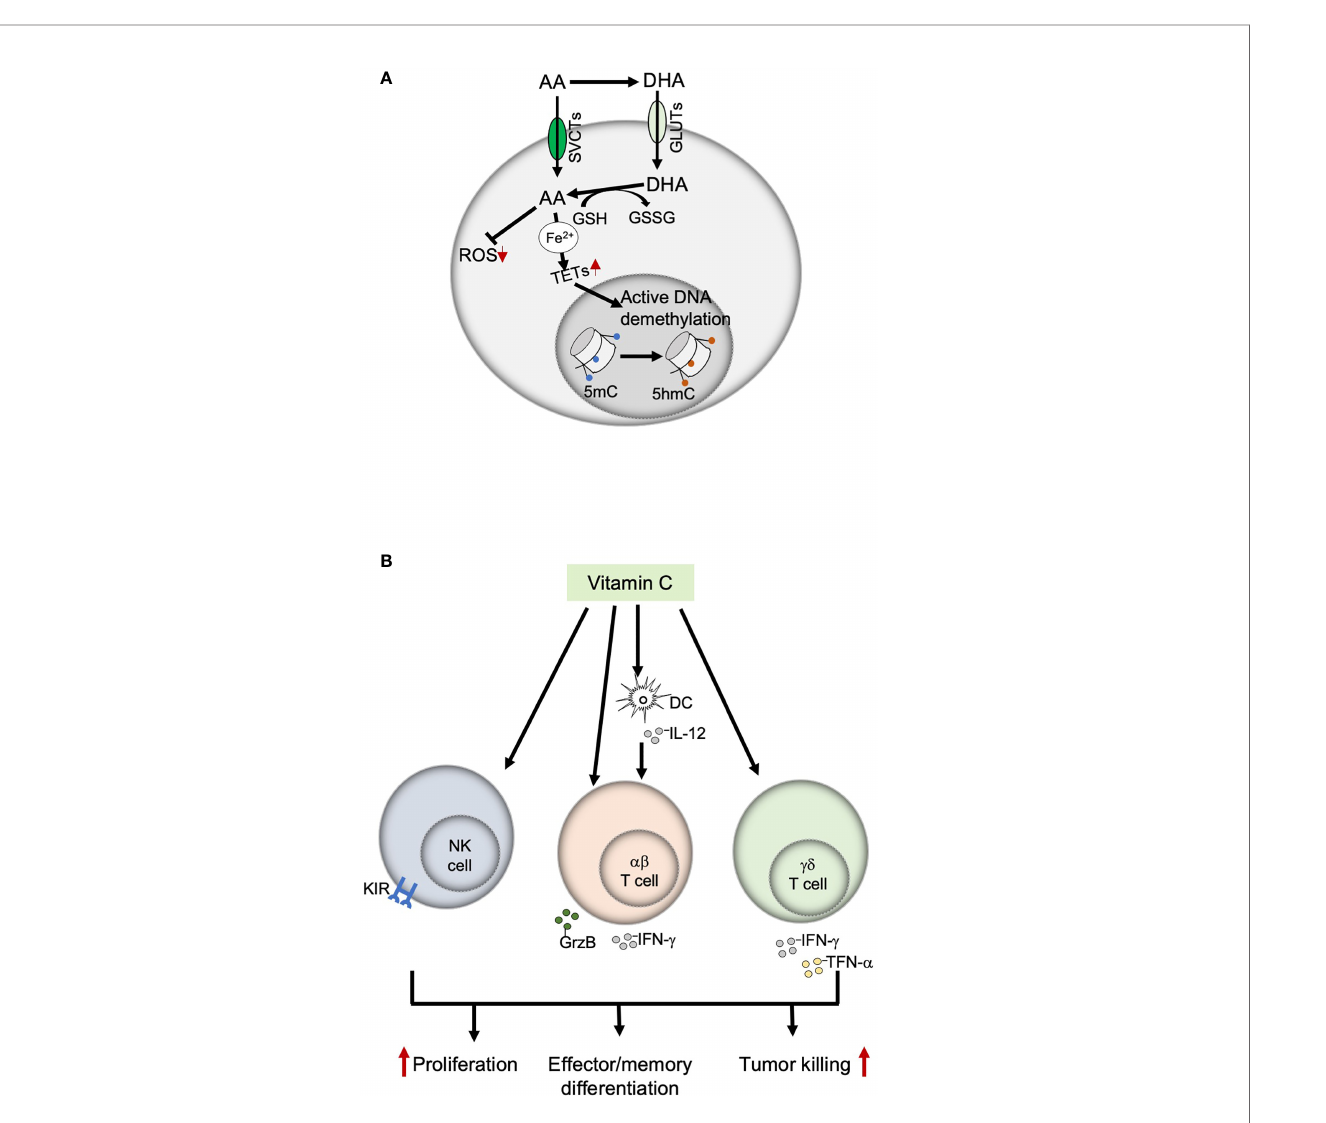
FIGURE 2 | Immunomodulatory functions of Vitamin C. (A) Mechanisms of action of Vitamin C; VitC exerts an immune-modulatory effect on immune cells through two main mechanisms, antioxidant activity and epigenetic modulation (by providing ferrous iron to the TET enzymes, which maintains them in their fully catalytic form, thereby ensuring an active DNA demethylation). (B) Effects of Vitamin C on immune cells with anti-tumor functions. VitC exerts both direct and indirect effects on NK, ab and gd T cells by modulating their proliferation, differentiation, and effector functions. AA, ascorbic acid; DHA, dehydroascorbic acid; GSH, glutathione; GSSG, glutathione disul fi de: SVCTs, sodium-dependent vitamin C transporters: GLUTs, glucose transporters: TETs, ten-eleven translocation enzymes; ROS, reactive oxygen species; 5mC, 5-methylcytosine; 5hmC,